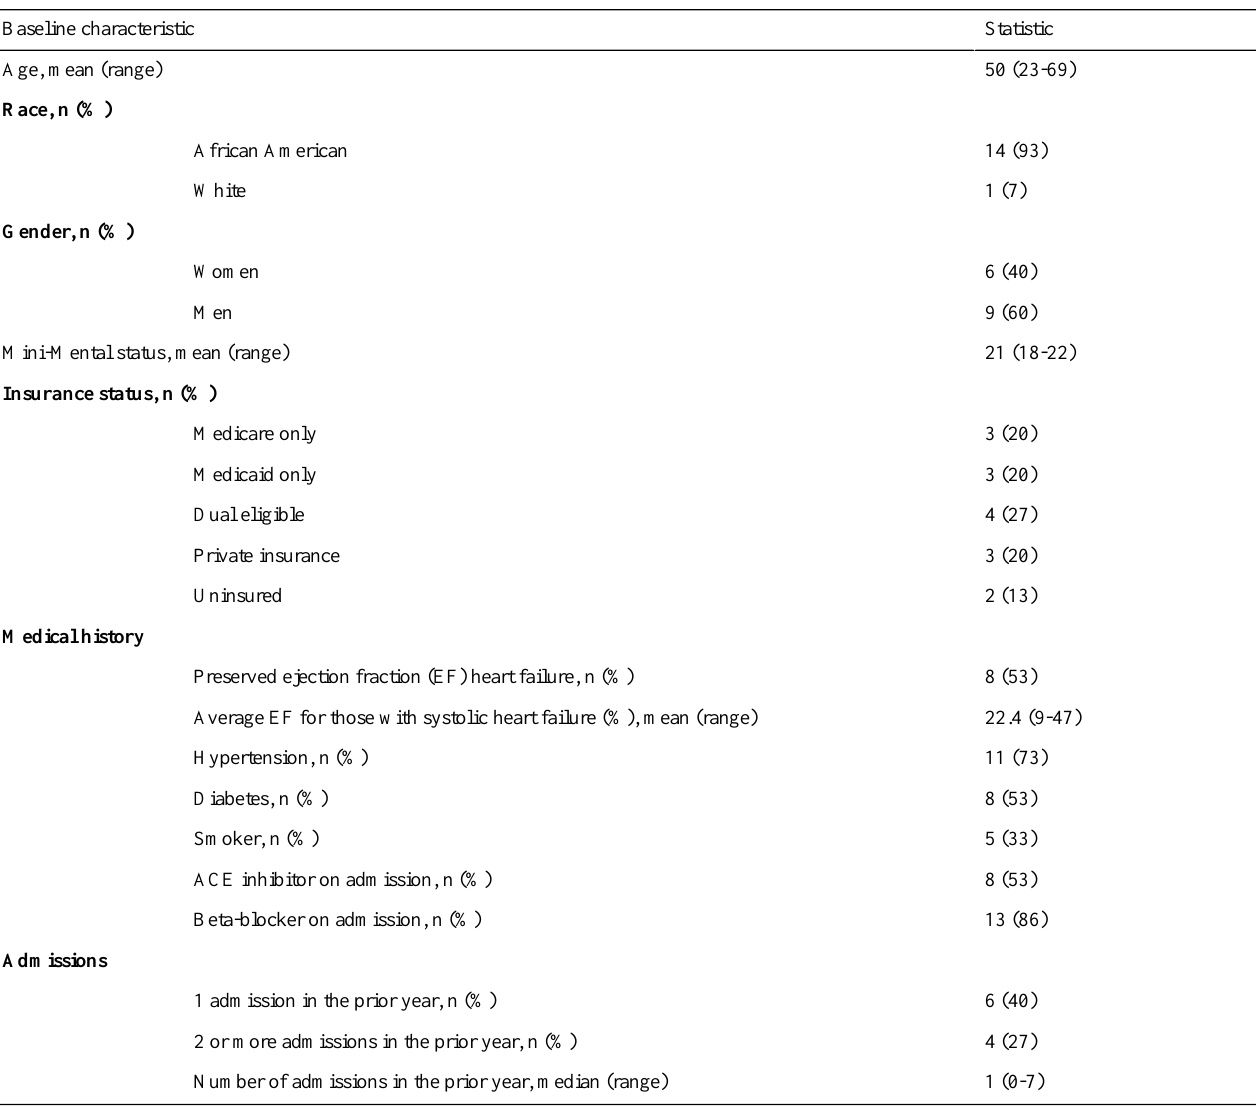
Table 1. Participant characteristics at enrollment